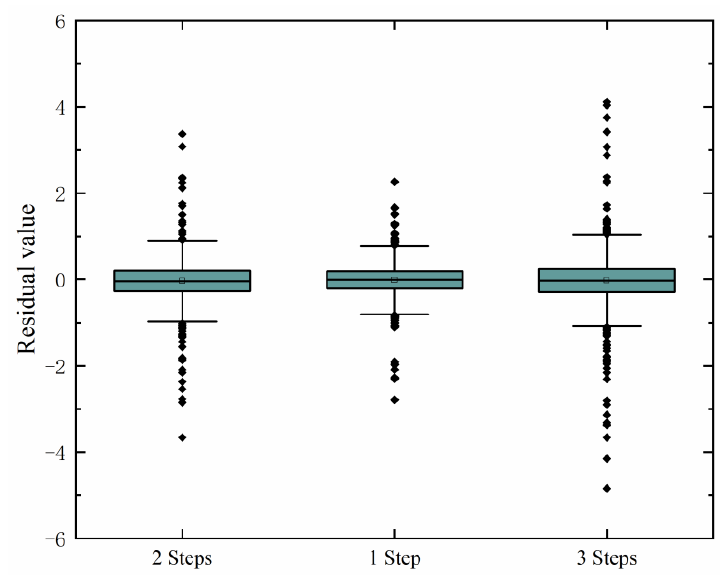
Figure 10. Boxplot of residual values at different forecast steps.